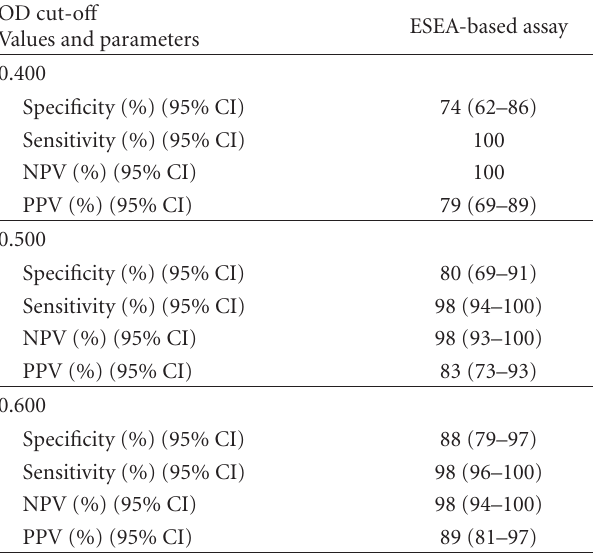
Table 1: Sensitivity, specificity, positive predictive values, and negative predictive values of the ESEA-ELISA at various arbitrary OD cut-o ff